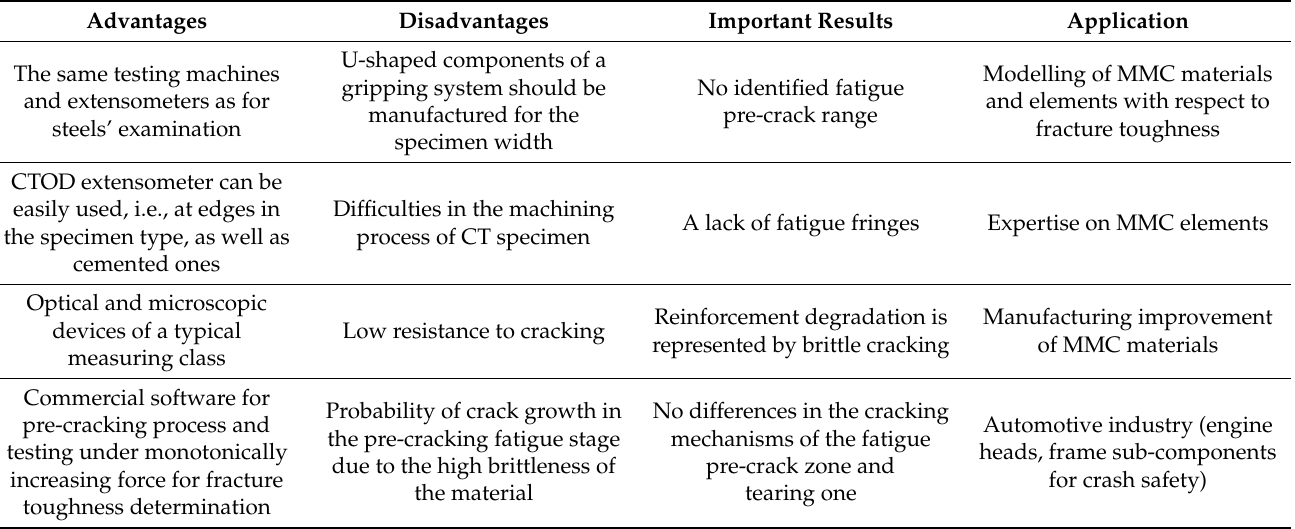
Table 1. Advantages, disadvantages, important results, as well as applications from the fracture